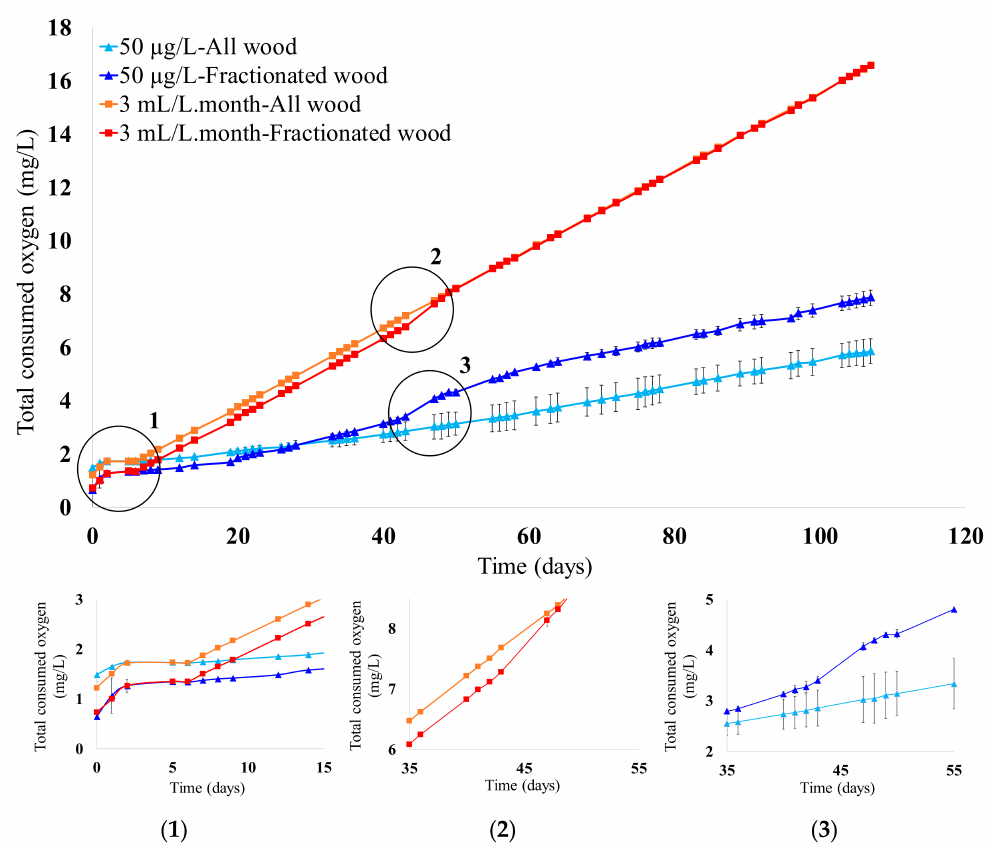
Figure 3. Graphic representation of MOX total consumption of oxygen (TCO mean, mg/L) in wines treated with two micro-oxygenation strategies. (cid:78) : floating MOX strategy (50 µ g/L) and all chips added at the beginning of the experiment; (cid:78) : floating MOX strategy (50 µ g/L) and half of the chips added at the beginning and the other half 48 days later; (cid:4) : fixed MOX strategy (3 mL/L · month) and all chips added at the beginning of the experiment; (cid:4) : fixed MOX strategy (3 mL/L · month) and half of the chips added at the beginning and the other half 48 days